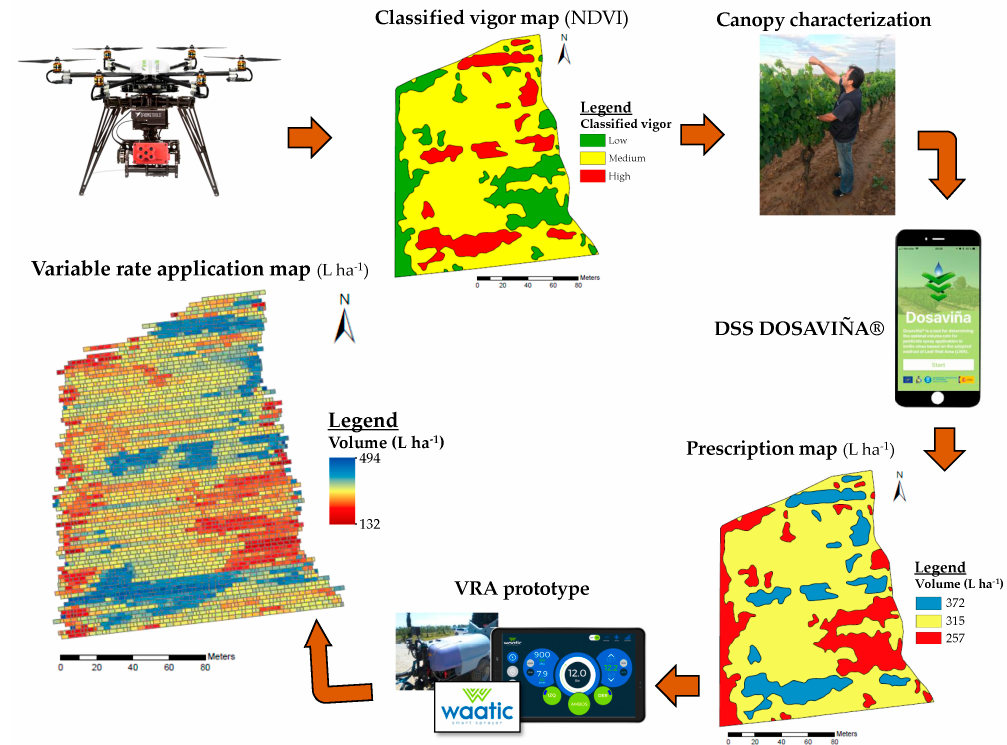
data; (2) generation of prescription maps for variable spray application based on canopy maps; (3) development of software and hardware to adapt a conventional sprayer into a Variable Rate Application (VRA) sprayer; and (4) generation of actual application rate map and monitoring of the results.